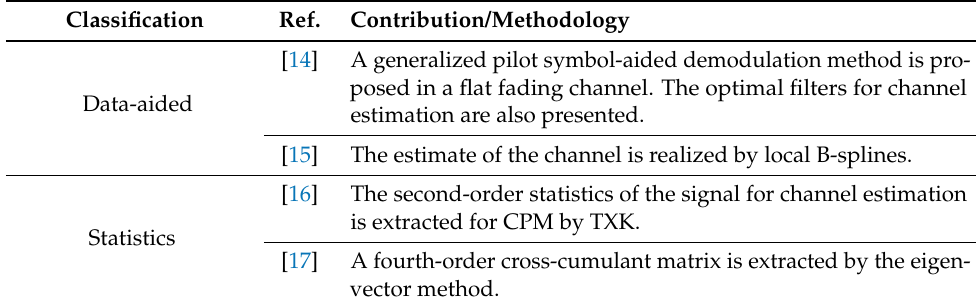
Table 1. Summary of the related